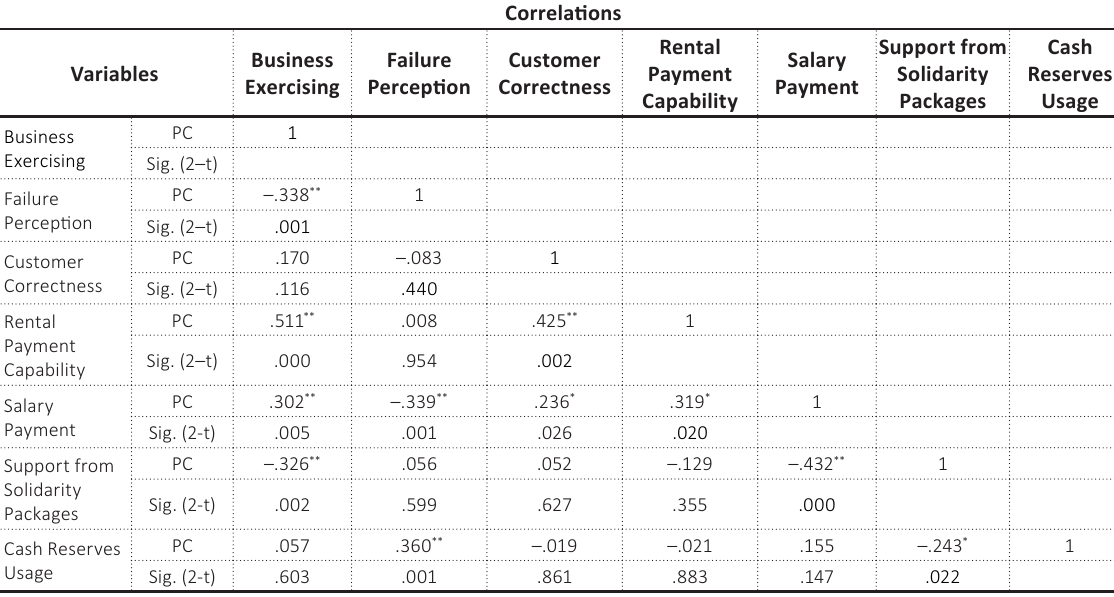
Table 2. Correlative bivariate relationships between the variables included in the study